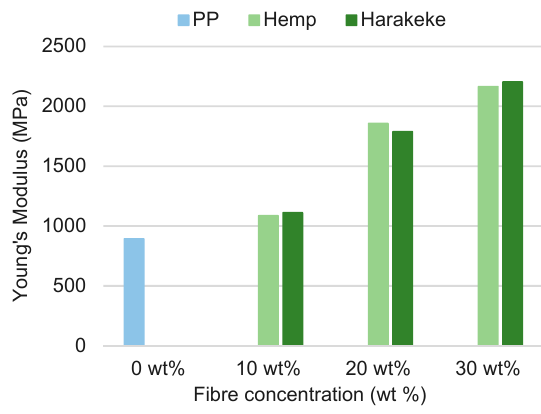
Figure 11. Young’s modulus of fiber reinforced filaments.